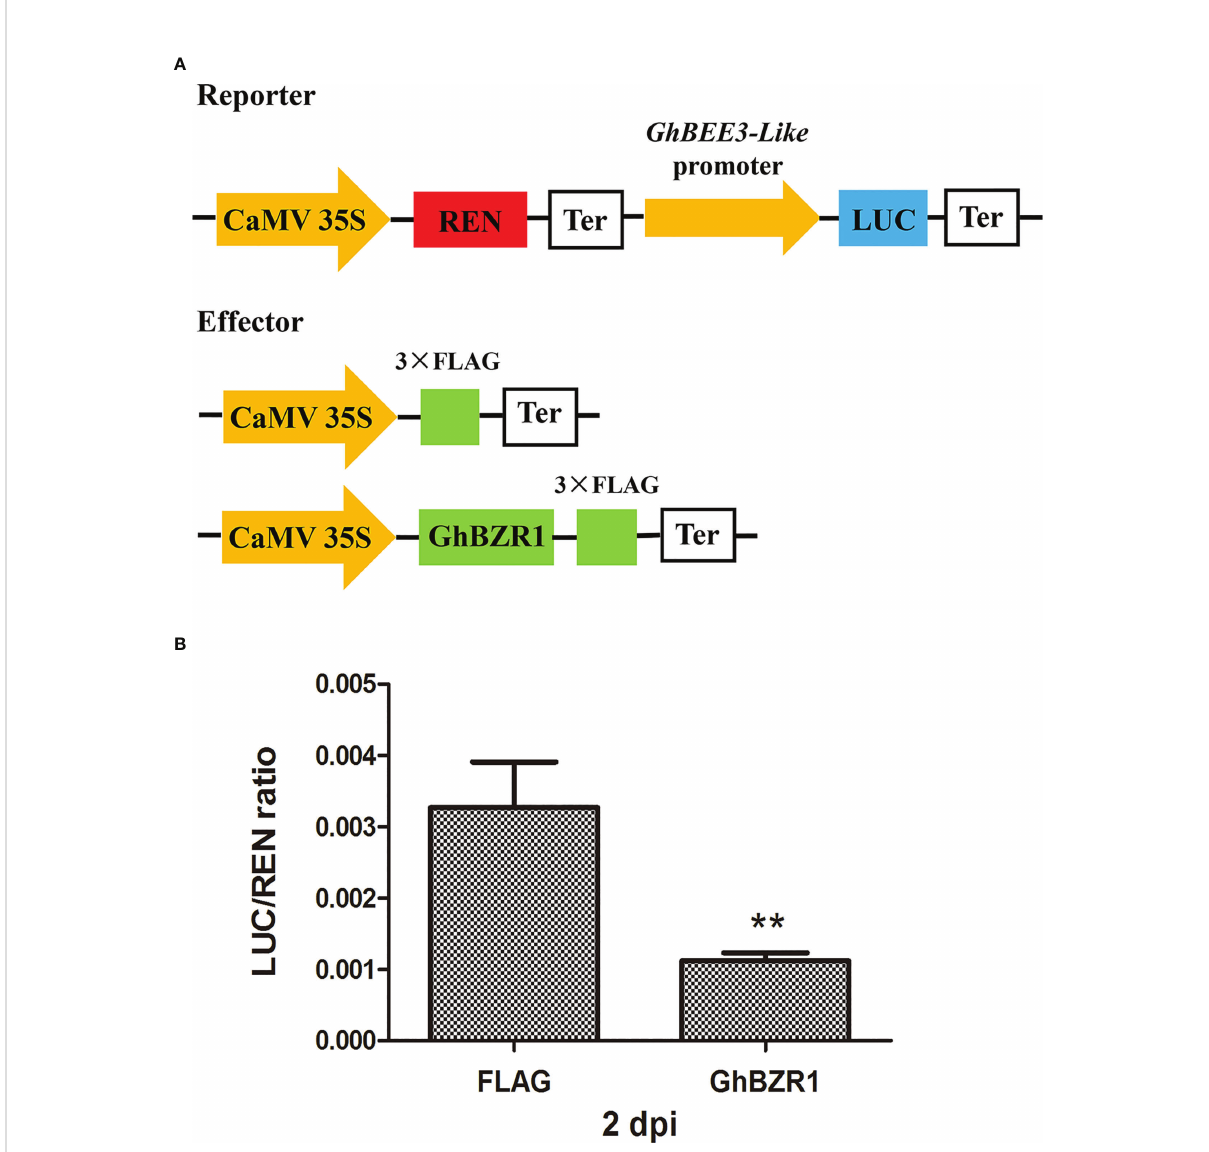
FIGURE 5 GhBZR1 inhibits the GhBEE3-Like expression in vivo . (A) Schematic model of reporter and effector plasmids used for the dual luciferase report assay. The dual-reporter plasmid contains GhBEE3-Like promoter sequences fused to LUC luciferase, and REN driven by CaMV35S promoter was used as internal reference. The effector plasmid contains GhBZR1 or FLAG control. LUC, fi re fl y luciferase; REN, renilla luciferase; Ter, terminator sequence. (B) Dual luciferase assay showing the expression inhibition of GhBEE3-Like by GhBZR1 TF. The ability of GhBZR1 to regulate the reporter LUC gene was indicated by the ratio of LUC to REN. Asterisks denote signi fi cant differences by Student ’ s t -test, **P < 0.01. dpi, days